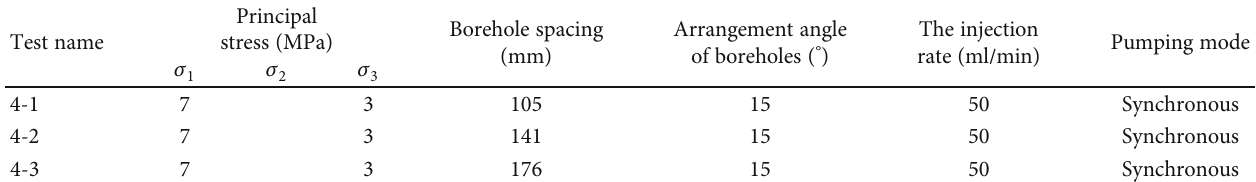
Table 6: Experimental scheme of directional hydraulic